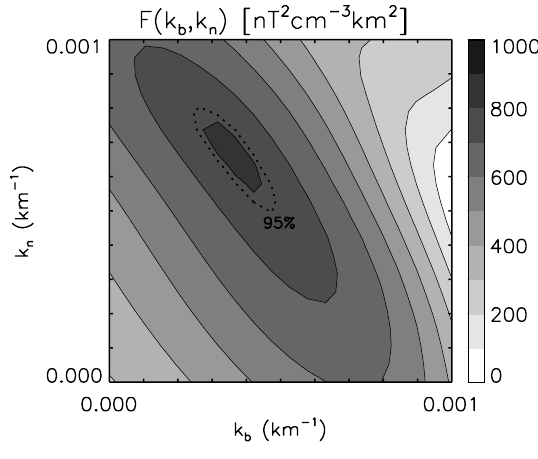
Fig. 4. Bispectrum for the Cluster observation in the foreshock with the same style as Fig. 2. The dotted line denotes the level of 95%